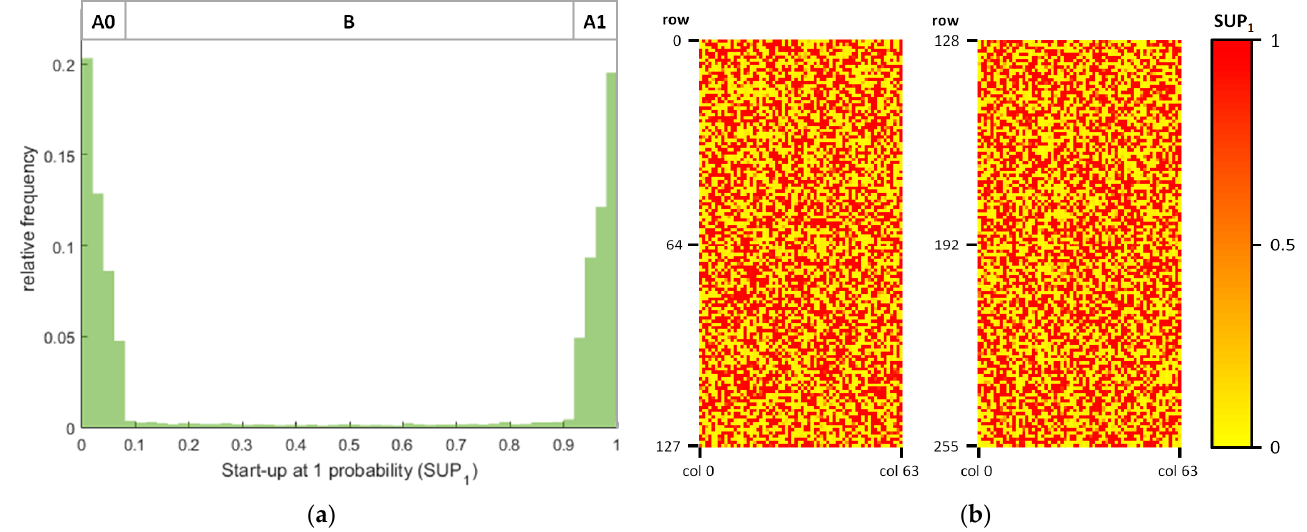
Figure 3. ( a ) Histogram of the relative frequency of cell as a function of the SUP 1 (start-up at logic ‘1’ probability) obtained from experimental data. Three different regions (A0, B, and A1) can be established. ( b ) Representation of the SUP 1 for each different cell in the cell matrix (256 rows × 64 columns) as a function of its location. The matrix is split in two parts for visualization purposes only.